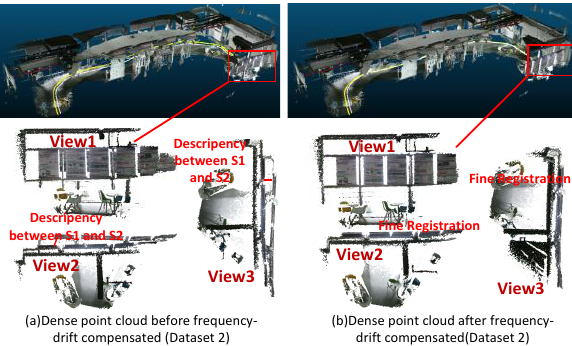
Figure 7. Comparison of the dense point cloud between before and after Fd-C of